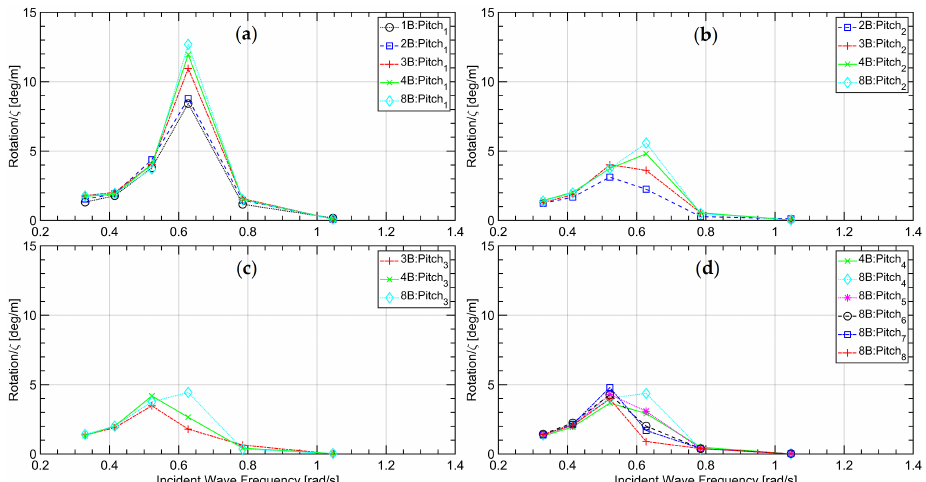
Figure 8. RAOs of pitch response of the five test cases for the chain configuration, where n B denotes the configuration with n bodies; subscript n , the corresponding n -th body’s motion response: ( a ) the 1st module; ( b ) the 2nd module; ( c ) the 3rd module; ( d ) the 4th–8th modules.